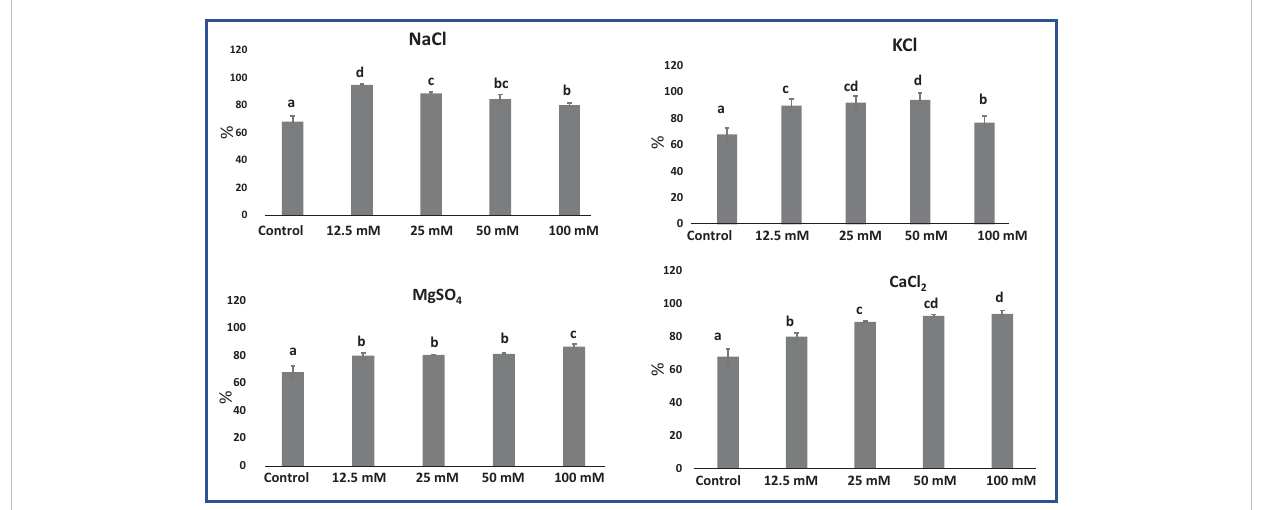
FIGURE 4 Effect of 12.5, 25, 50, and 100 mM concentrations of NaCl, KCl, MgSO 4 , and CaCl 2 salts on electrolyte leakage (%) in an M. longifolia leaf sample. The data are represented as mean ± standard deviation (n = 3). The different letters on the bar graph show the signi fi cantly different groups according to the Duncan test ( a =